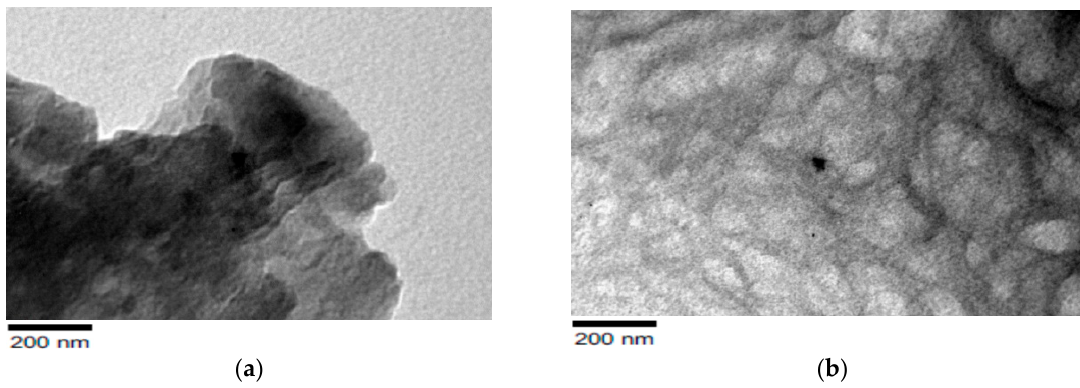
Figure 5. TEM images of organoclay ( a ) before modification and ( b ) after modification with octadecyl amine, reprinted from [7].